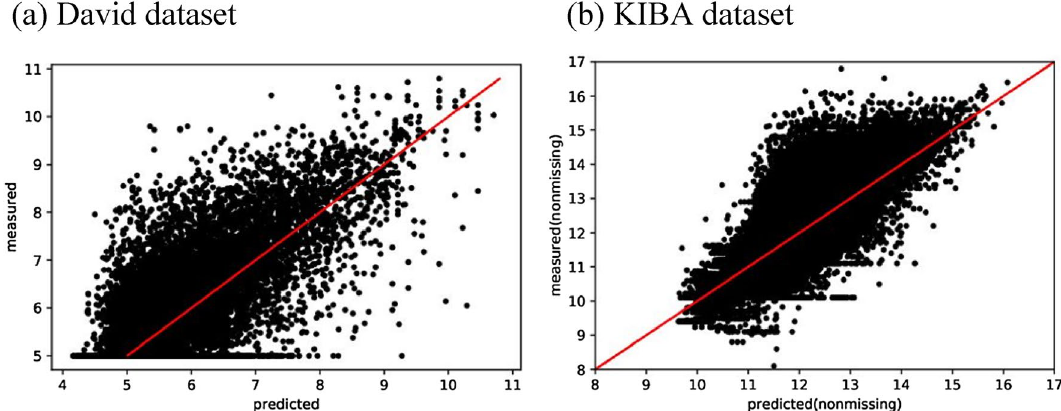
Figure 3. Scatter plots of predictions of SimCNN-DTA versus measured binding affinity values for Davis ( pK d ) and KIBA (KIBA score) datasets. PubChem